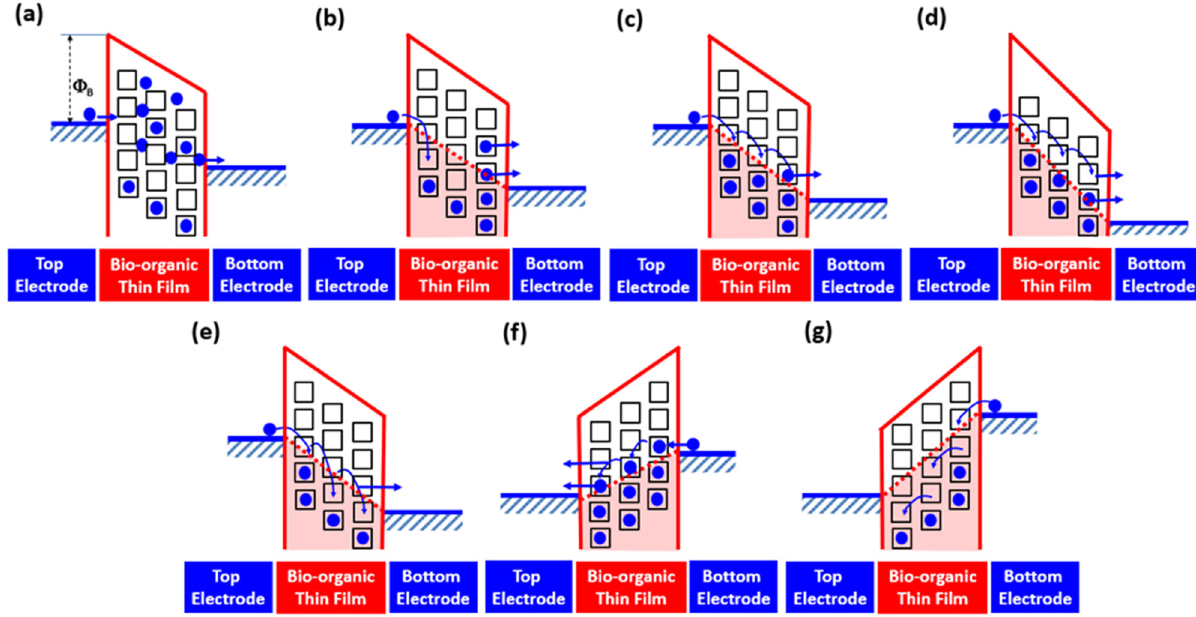
Figure 10: Energy band diagram representing the movement of electrons through the bio - organic thin fi lm with increasingly negative bias ( a ) – ( d ) at the top electrode and reverse positive shown in ( e ) – ( g ) . HRS consists of ( a ) ohmic ’ s, ( b ) trap fi ll - limited, and ( c ) the Mott – Gurney conduction and LRS is shown in ( d ) – ( f ) ; then transits back to HRS in ( g ) . and represent electrons and traps, respectively. Blue arrows show the fl ow of electrons. The red region within the dielectric and under the dotted red lines connecting work functions of two electrodes indicate a higher probability for traps to be fi lled by electrons and any traps above the red dotted lines are high to be unoccupied by